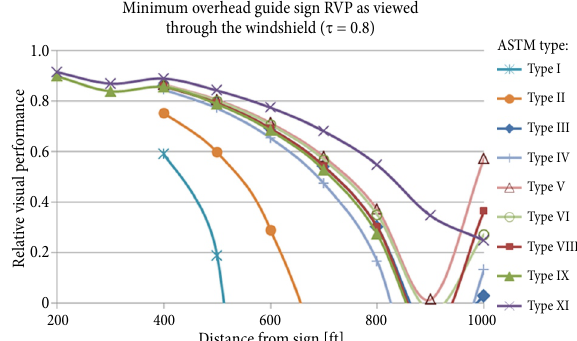
Fig. 3. Minimum RVP values for each ASTM D4956-16 sign material type, as a function of viewing distance,